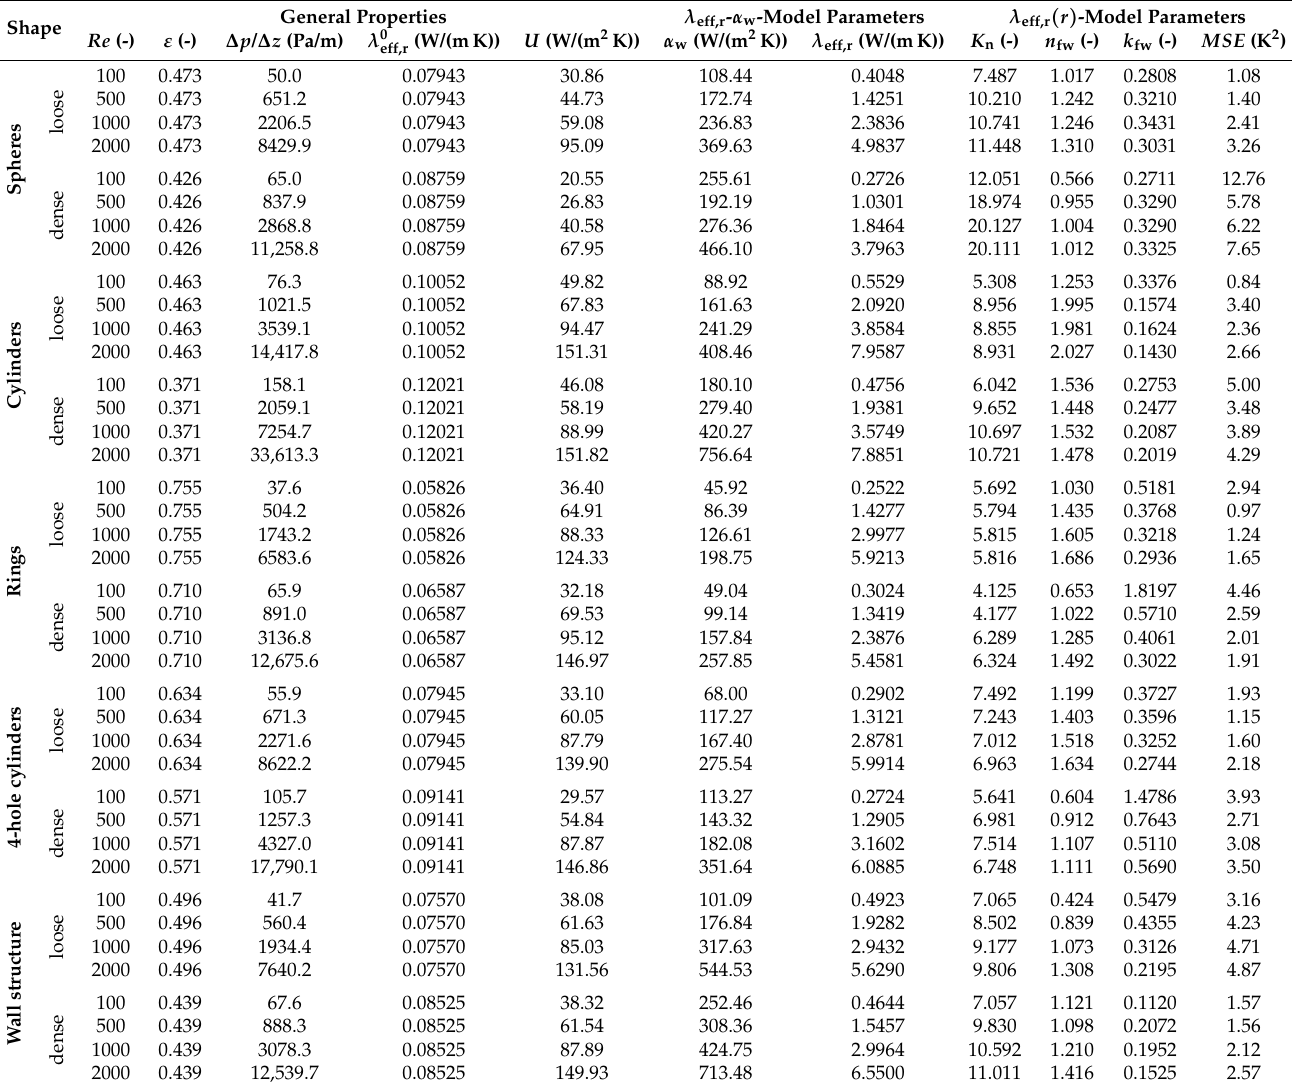
Table 2. Summary of important results and simulation